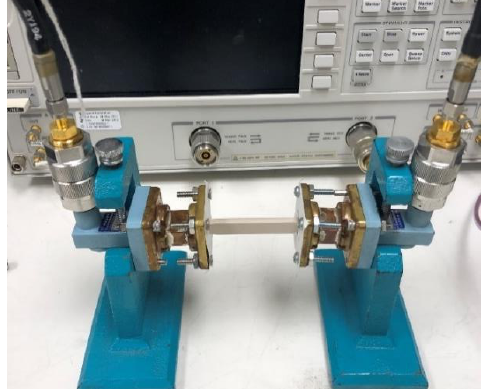
Figure 3. Measurement set up for printed dielectric waveguide.